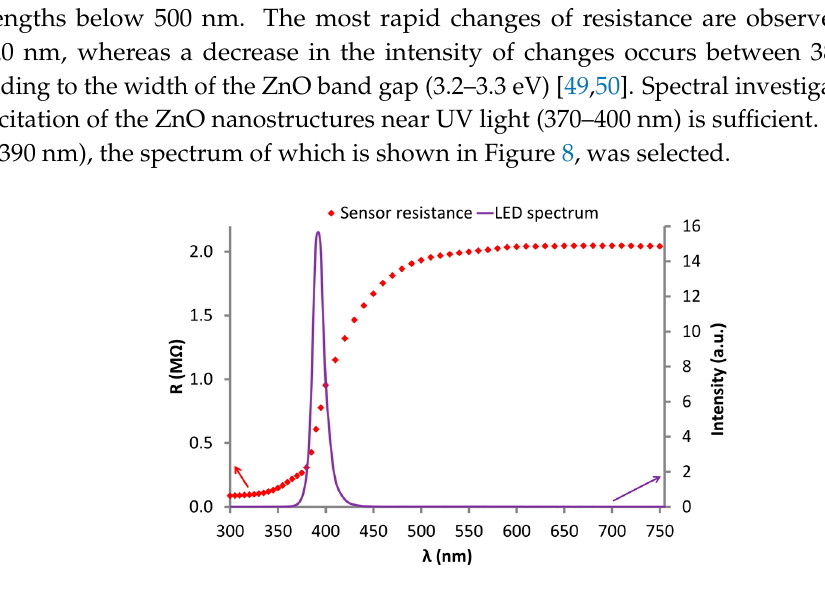
Figure 8. The relationship of the resistance of the ZnO nanostructures on the wavelength R( λ ) (at ambient conditions) and the UV LED spectrum (violet line).